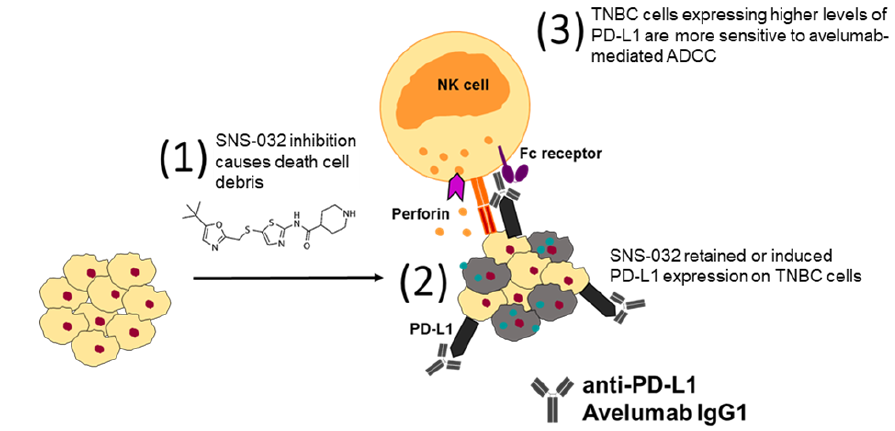
Figure 6. A model depicting possible mechanisms behind the combination treatment of small-molecule CDK inhibitors with anti-PD-L1 checkpoint antibody. ( 1 ) It is thought that treatment with CDK inhibitor SNS-032 led to the dysregulation of cell cycle and generated cytotoxicity against tumor cells, whereas death cell debris (grey cells and green dots) activated anti-tumor immune surveillance and triggered the recruitment of lymphocytes into the tumor microenvironment. ( 2 ) SNS-032 inhibition upregulated PD-L1 expression on the surviving TNBC cells which could increase susceptibility to checkpoint inhibition. Treatment with avelumab resulted in blockade of the PD-1/PD-L1 axis between immune cells and cancer cells. ( 3 ) Avelumab enhanced NK-cell-mediated perforin-dependent cytotoxicity, initiated by the ligation of Fc receptors from avelumab-bound tumor cells to FcγR expressed on NK cells, which led to tumor cell apoptosis. TNBC cells expressing higher levels of PD-L1 are more sensitive to avelumab-mediated ADCC. A combination of CDK inhibition with anti-PD-L1 checkpoint blockade could promote immune cell recruitment into tumors and